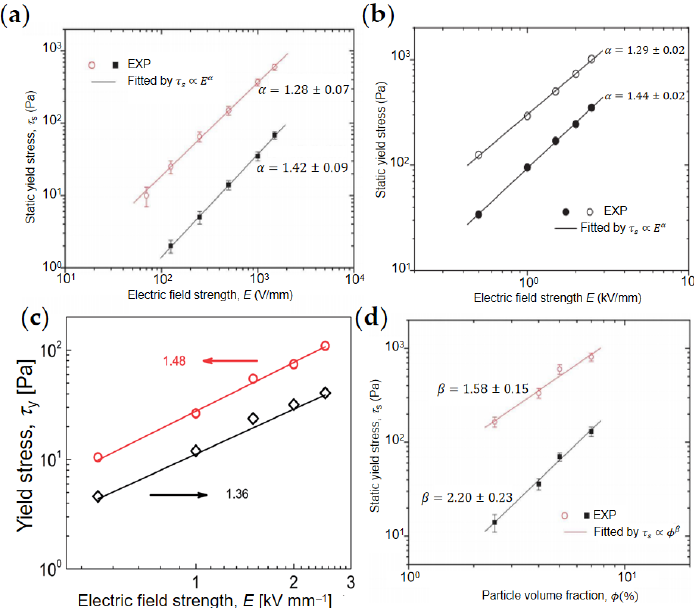
Figure 12. Yield stress–electric field intensity relationship of ER fluids of rGO/PPy (open circle point) and pure granular PPy (solid square point) ( a ) [84], graphene ‐ supported carbonaceous sheets (open points) and pure carbonaceous particles (solid points) ( b ) [89], neat GO ( ◇ ) and GO ‐ PBMA ( ○ ) ( c ) [79]; Yield stress ‐ particle volume fraction relationship of ER fluids of rGO/PPy (open circle point) and pure granular PPy (solid square point) ( d ) [84].